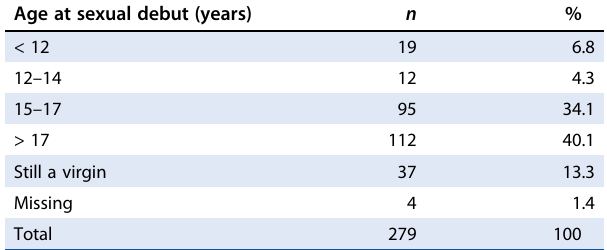
Table 4: Participants ’ sexual